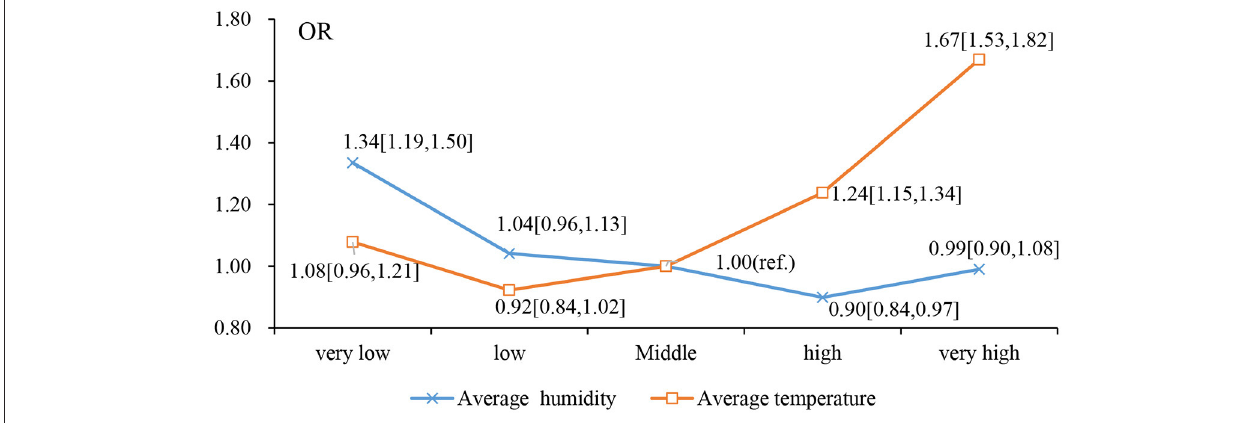
cataracts at a higher rate than those exposed to 24 cause age-related cataracts (34). Studies in animals have shown (35). Furthermore, organ cultured rat lenses incubated at 40– that cataracts may develop when the temperature of the eye’s lens increases with the temperature of its surroundings. Brown 50 ◦ C developed cortical cataracts (36). Evidence generated from Norway rats exposed to 35 2 ◦ C for 3 weeks developed animal models is not directly comparable to that in ±